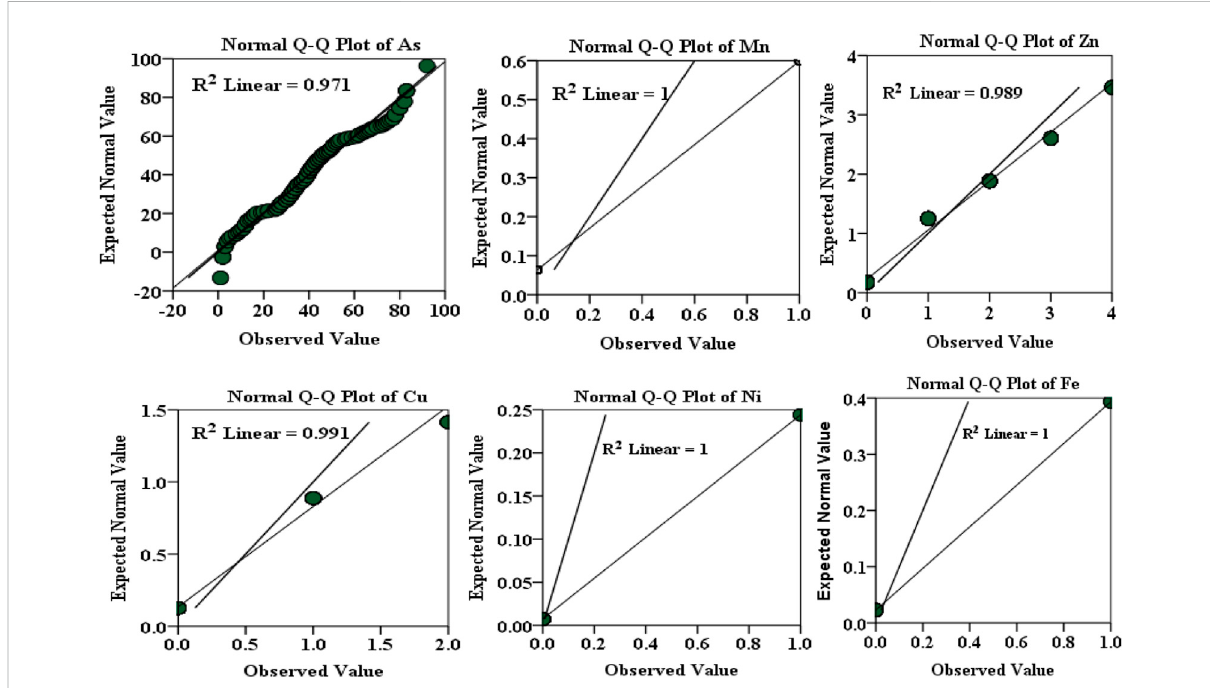
FIGURE 5 Quantile-Quantile (Q-Q) plotting shows distribution of the groundwater variables in the study